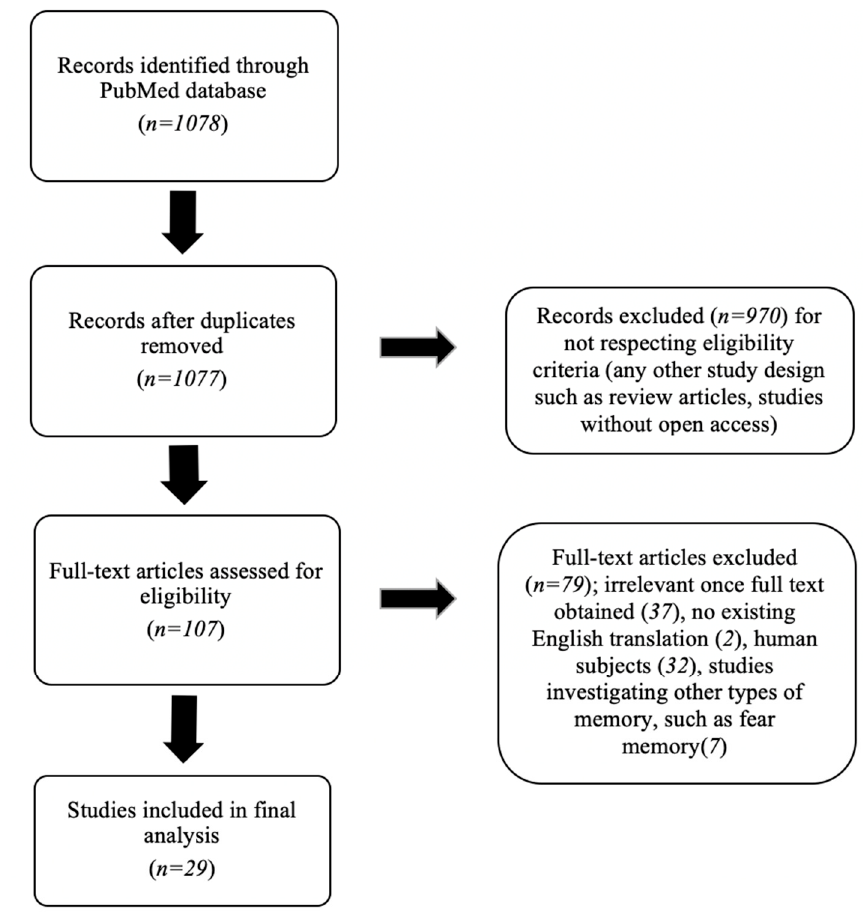
Figure 1. Flow diagram of the